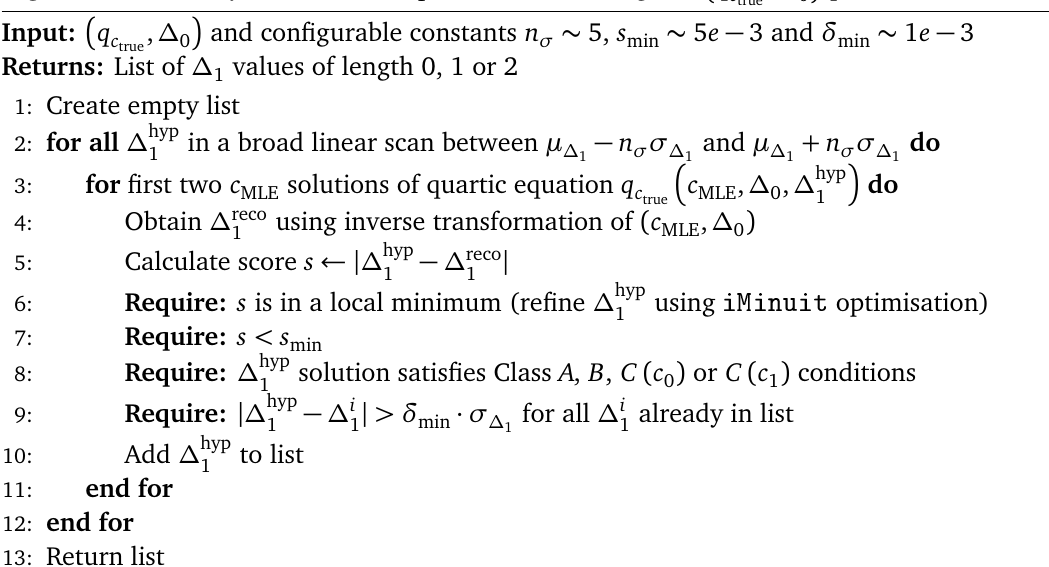
Algorithm 1 Identify all values of ∆